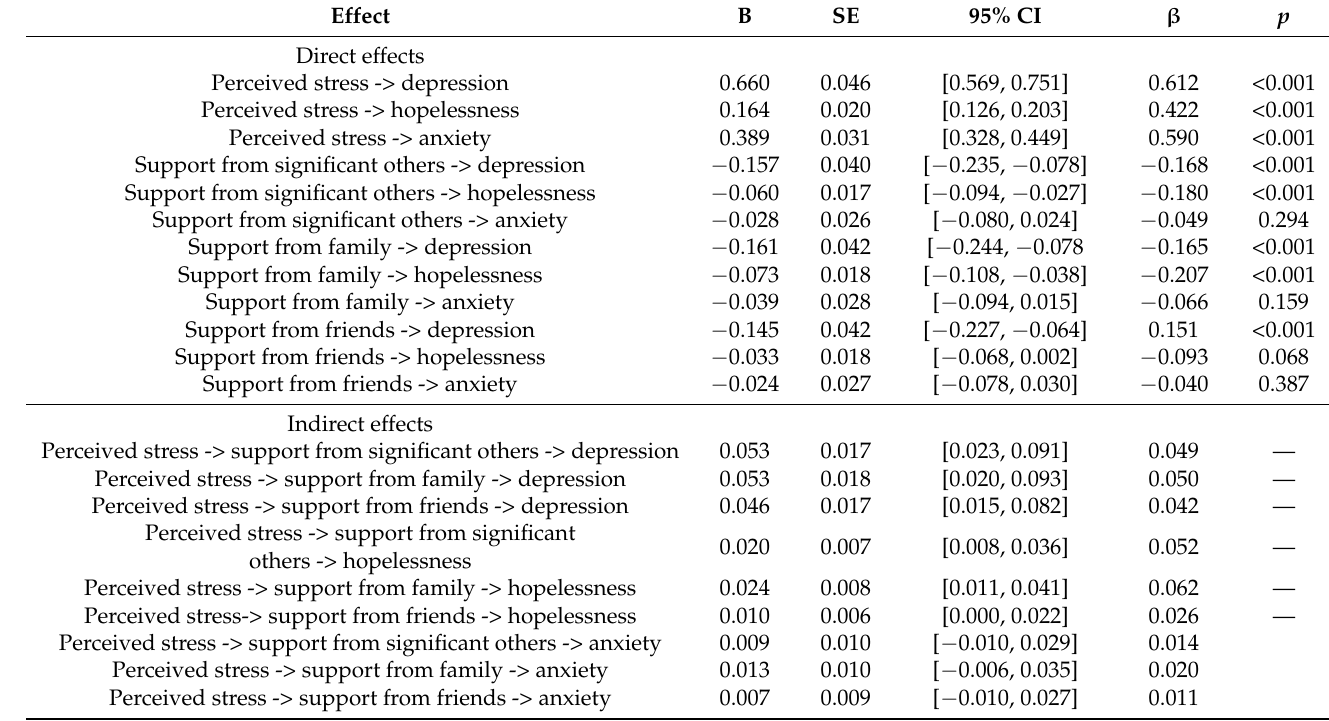
Table 3. The direct and indirect effects of perceived stress and the dimensions of social